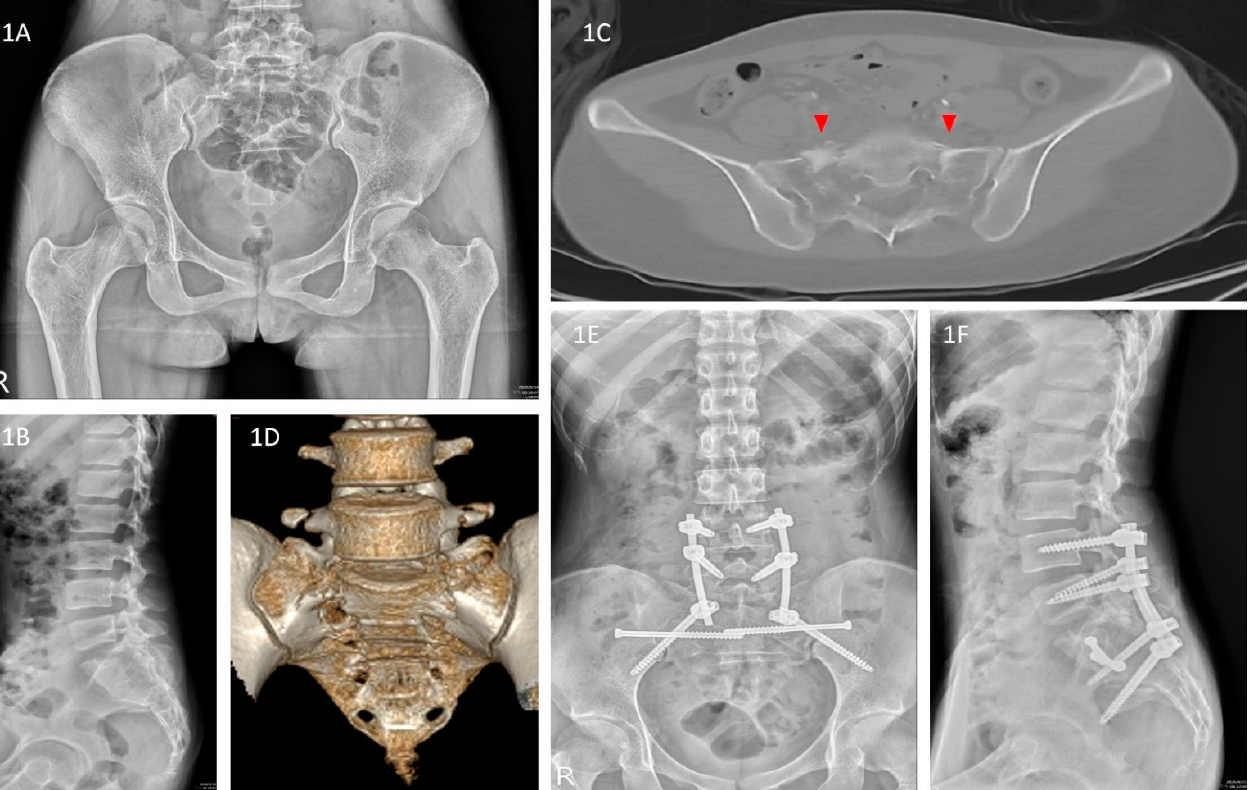
Figure 1. ( 1A–1F ) Pre- and postoperative radiography and CT images of a 21-year-old woman who fell from a bridge and developed bifrontal EDH, facial bone fractures, and bilateral sacral fractures with spinopelvic dissociation that were presented in the emergency room. ( 1A ) AP view of the pelvis on admission showing bilateral fracture lines on the sacrum; ( 1B ) lateral view of the sacral spine view on admission showing fracture lines on the sacrum, indicating displaced fragments over the fracture site; ( 1C ) axial CT view of the sacrum demonstrating bilateral fracture lines indicating U- type sacral fractures; ( 1D ) 3D CT view of the sacrum demonstrating a displaced U-shape sacral fracture (red arrows) and AO/OTA 54C3 type, Denis Zone II sacral fracture. ; ( 1E )Postoperative AP pelvic view: the sacral fracture was stabilized by bilateral triangular osteosynthesis with S2AI screws. ( 1F ) Postoperative lateral view of the sacral spine: The trajectory of S2AI screws was set under O-arm navigation to obtain an optimal length. Abbreviations: EDH = epidural hematoma, CT = computed tomography, and AP = anteroposterior.